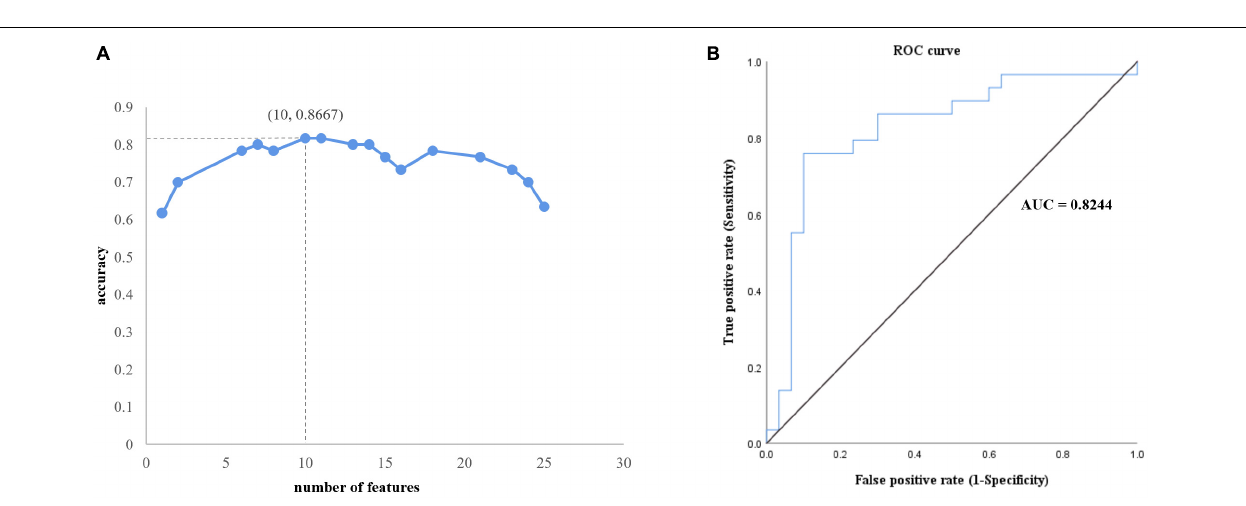
FIGURE 2 | Results of behavioral tasks pre- and post-training. (A) The level of radiological expertise assessed by the radiological expertise task. The radiology interns had a significantly greater scores after training compared with scores before training ( p < 0.001, Mann-Whitney U -test), indicating improved performance in visual recognition of radiological images. (B) Response time of radiological expertise task pre- and post-training. The radiology interns had a significantly faster in behavioral response after training compared with that before training ( p < 0.001, Mann-Whitney U -test). (C) The level of face expertise measured by the Cambridge face memory test. No significant differences were found ( p = 0.19, Mann-Whitney U -test). RET, radiological expertise task; RT, response time; CMFT, Cambridge face memory test. Error bars indicate the standard deviation. * indicats the significant differences between groups ( p < 0.001).